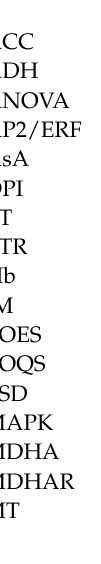
Table S1: List of primers used for quantitative real-time PCR (qRT-PCR) analysis of sweet potato